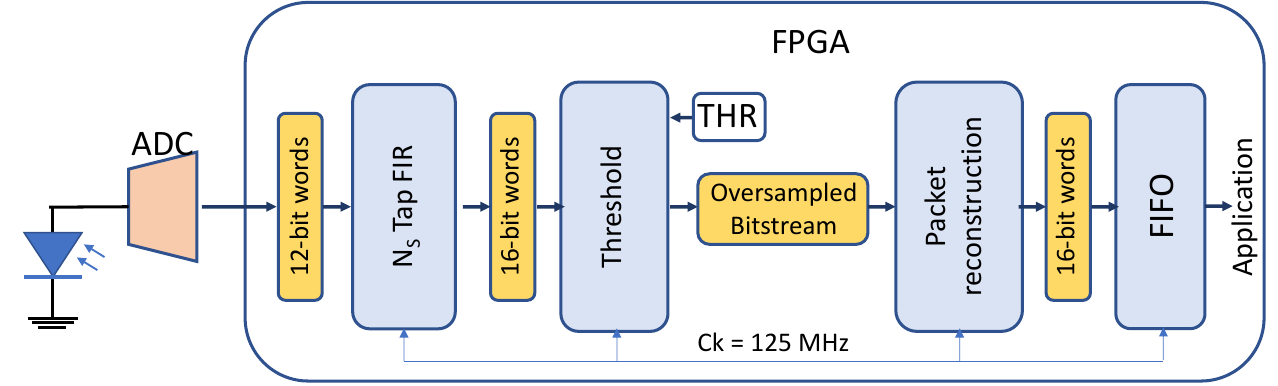
Figure 7. Architecture of the receiver.